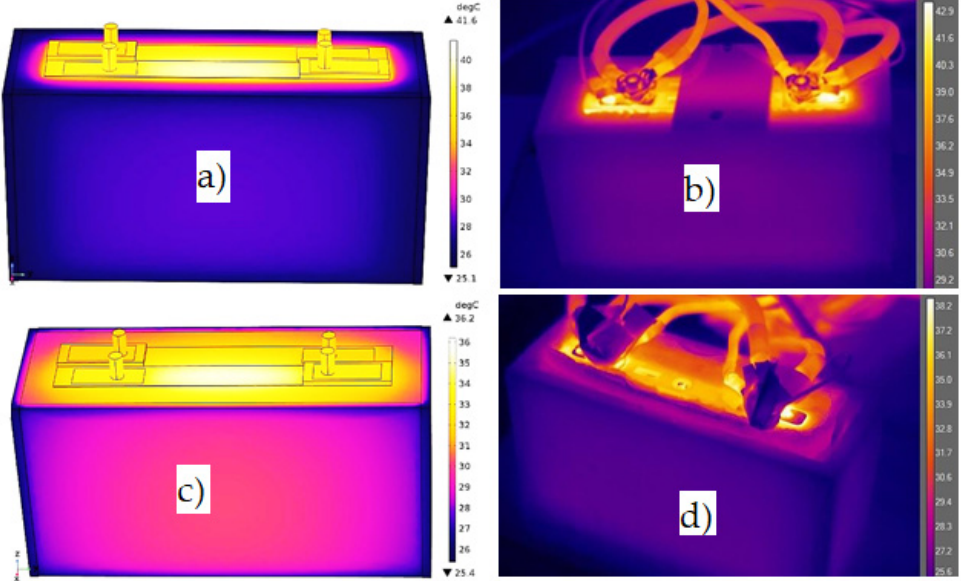
Figure 10. ( a ) Simulation result for the pure PCM; ( b ) experimental result for the pure PCM taken by the thermal camera; ( c ) simulation result for the PCM-Al; ( d ) experimental result for the PCM-Al taken by the thermal camera [46].